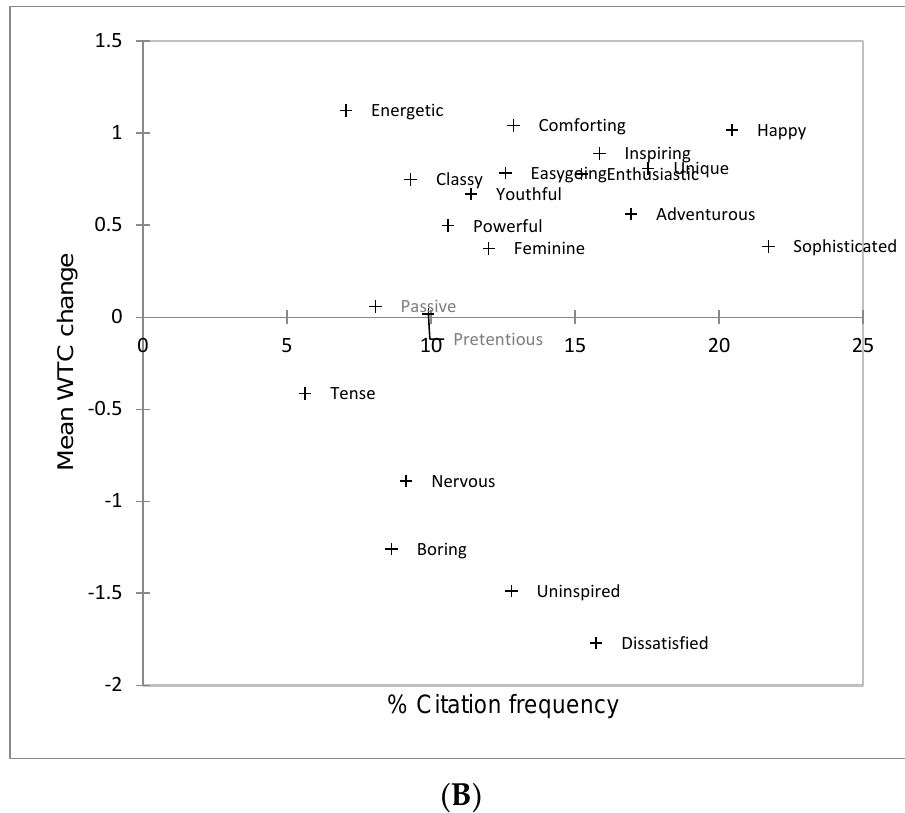
Figure 2. Results linked to emotional and conceptual product associations for aggregate sample across 2494 consumers in USA, Australia, Singapore and India shown for aggregate sample the five plant-based (PB) food categories included in the research. ( A ) Plot of the first two dimensions following Correspondence Analysis; ( B ) Impact on average willingness to consume (WTC) based on Penalty/Lift analysis. In ( A ), PB food categories are shown in bold and italic font. In ( B ), grey font used for terms where change in WTC is not significantly different from zero at the 5% level of significance.